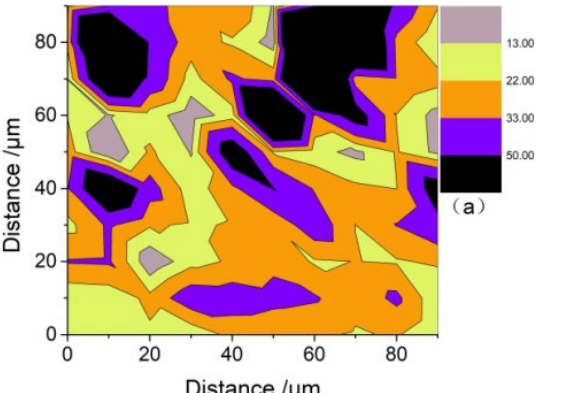
Figure 17. The most probable elastic modulus variation of samples at 28 days. 3.5.5. SEM Analysis Figure 18 shows the SEM results of the hardened slurry of OPC-LCFA at 28 days of hydration. The three SEM images in Figure 18 are taken from the same sample. The mi- croscopic morphology of straight AFt, fibrous C-S-H gel, and hexagonal sheet Ca(OH) 2 was observed. To further determine the effect of LCFA and FA on C-S-H gel formation in cement-based materials, the energy-dispersive spectrum (EDS) of the OPC-LCFA (O-L-2) sample and OPC-FA (O-F-2) sample was tested, and the results are shown in Figure 19. Figure 19a,b show EDS results of O-L-2 and O-F-2 samples, respectively. Figure 19c shows the contents of Ca, Si and Al in the EDS results of O-L-2 and O-F-2 samples. The figure shows that the Ca/Si and Ca/Al ratios on the hydrated surface of LCFA were 2.057 and 4.192, respectively. However, the Ca/Si and Ca/Al ratios on the hydrated surface of FA were 1.038 and 1.464, respectively. Therefore, C-S-H gel and C-A-H gel produced by OPC-